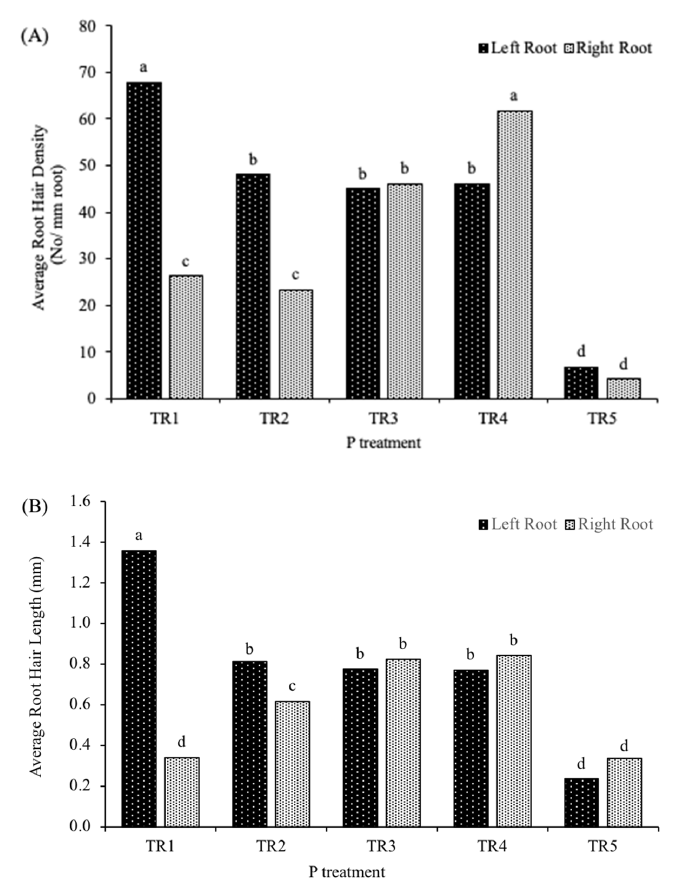
Figure 4. Measurement of root hairs of wild-type barley seedlings with different phosphorus (P) concentrations in the nutrient media in split-root treatments, ( A ) Average root hair density, ( B ) Average root hair length. For the measurements of root hair density and length, N = 10. Measurements were made 10 days after transferring (DAT) plants to the measurement solution. Different letters indicate significant differences ( p ≤ 0.05) among P levels of the wild-type seedlings according to a Tukey’s HSD test.